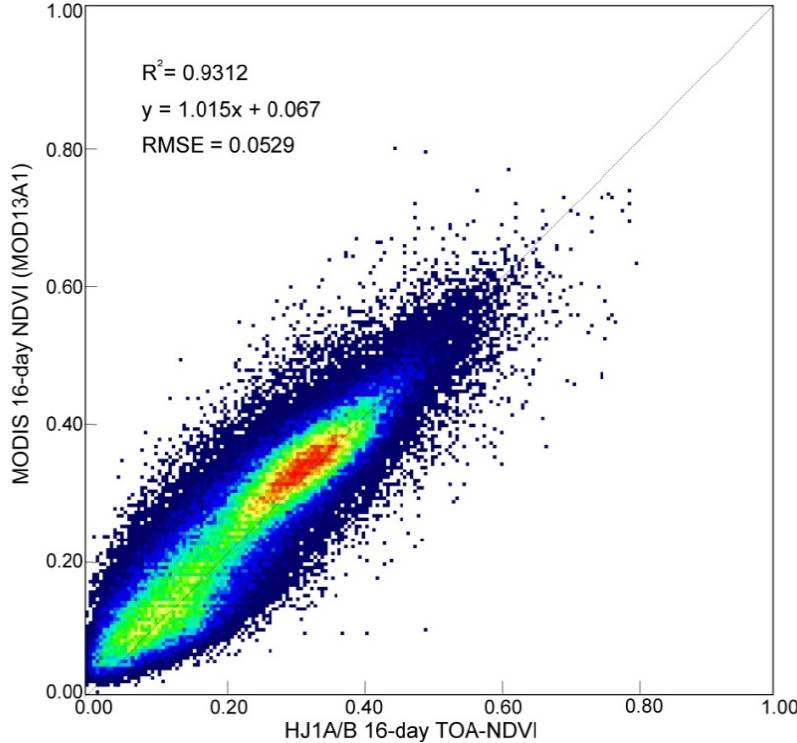
Figure 11. Scatter plot for the comparable samples in the year 2010 with HJ-1A/B 16-day composited TOA-NDVI as x-axis and MODIS 16-day NDVI (MOD13A1) as y-axis.